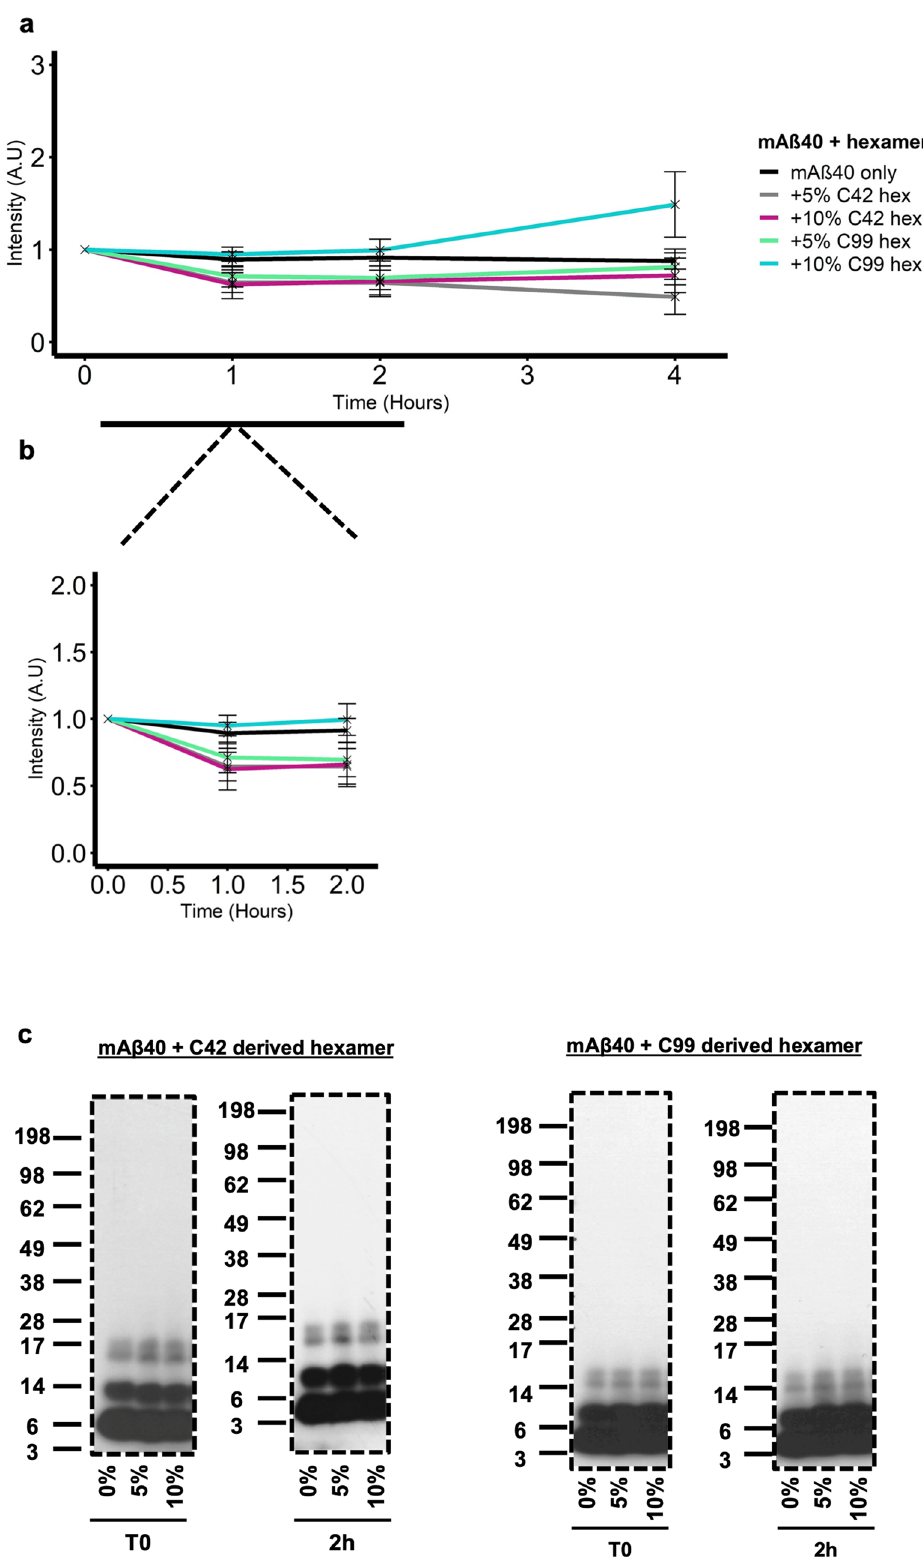
Figure 7. Isolated C42 and C99 derived hexameric Aβ do not readily nucleate monomeric Aβ40 (mAβ40). ( a ) 50 µM mAβ40 was seeded with 5- or 10% hexamer and the solution was then incubated with 20 µM ThT. Fluorescence was monitored over 4 h. ( b ) Addition of both 5- and 10% did not result in an increased fluorescence at early time points (0–2 h) ( c ) Western blotting detected with the W0-2 antibody revealed seeding conditions with both hexamers does not lead to the formation of higher molecular weight assemblies compared to mAβ40 only. Dashed borders indicate the membrane was cut before